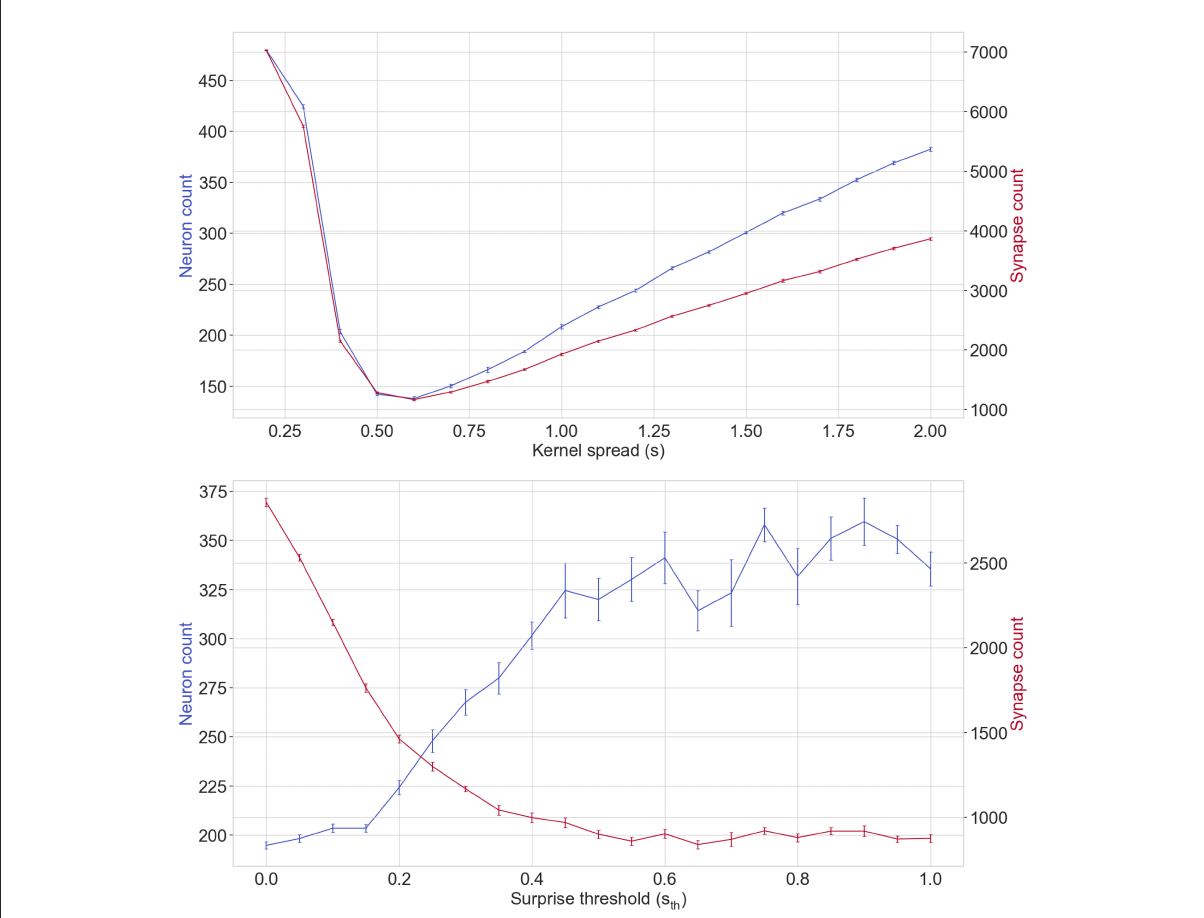
FIGURE11 Showing the effect of range of parameter values for kernel spread s (top) and surprise threshold s th (bottom) on neuron and synapse count after training on the wine classification task. The left y-axis and the line in blue of each plot corresponds with neuron counts. The right y-axis and the red line correspond with the synapse count. The vertical bars show the standard error over a stratified 10 fold cross